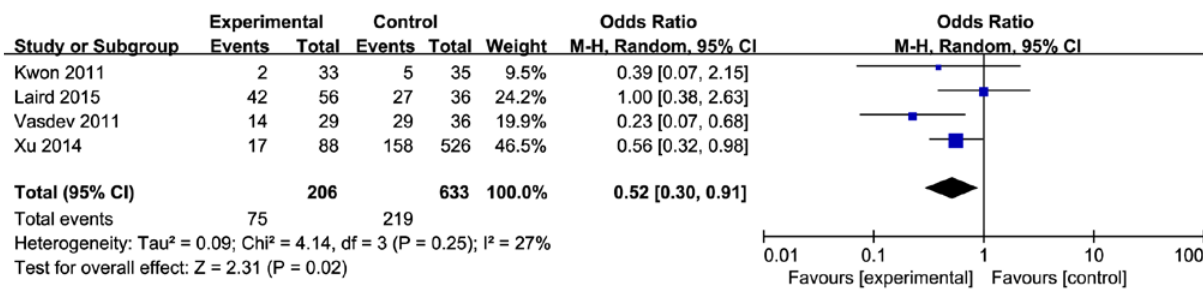
Figure 4: The forest plot for the post-operative length of hospital stay between LRN and ORN group